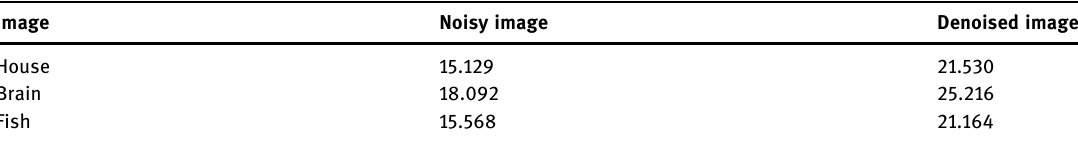
Table 4: PSNR results for noisy and denoised images in Example 5.4